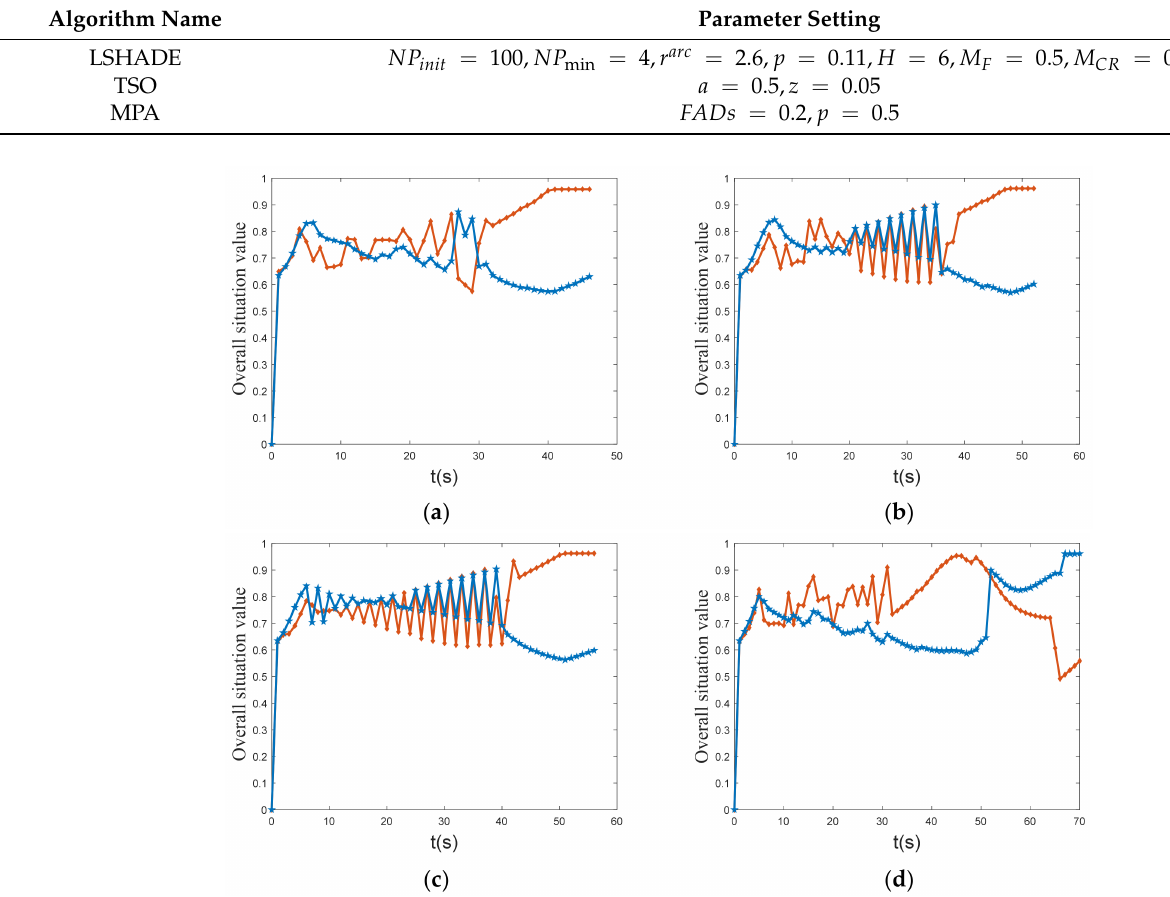
Figure 21. Overall situation values of four algorithms combined with the MPC framework against